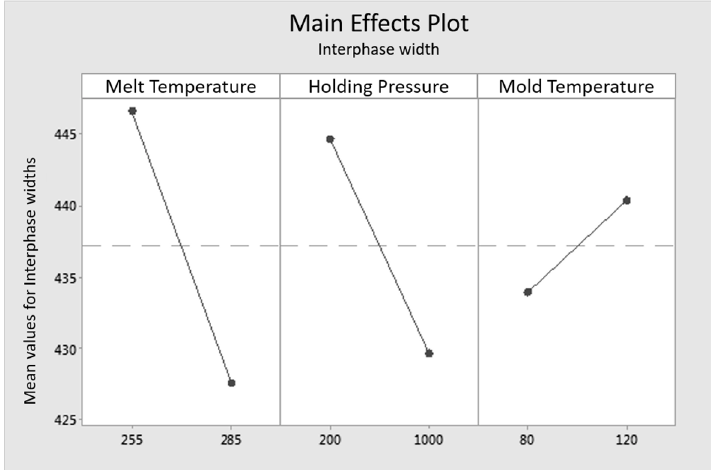
Figure 16. Main effects plot for the width of the overall interphase for the influencing factors “mass temperature”, “holding pressure” and “mold temperature”.